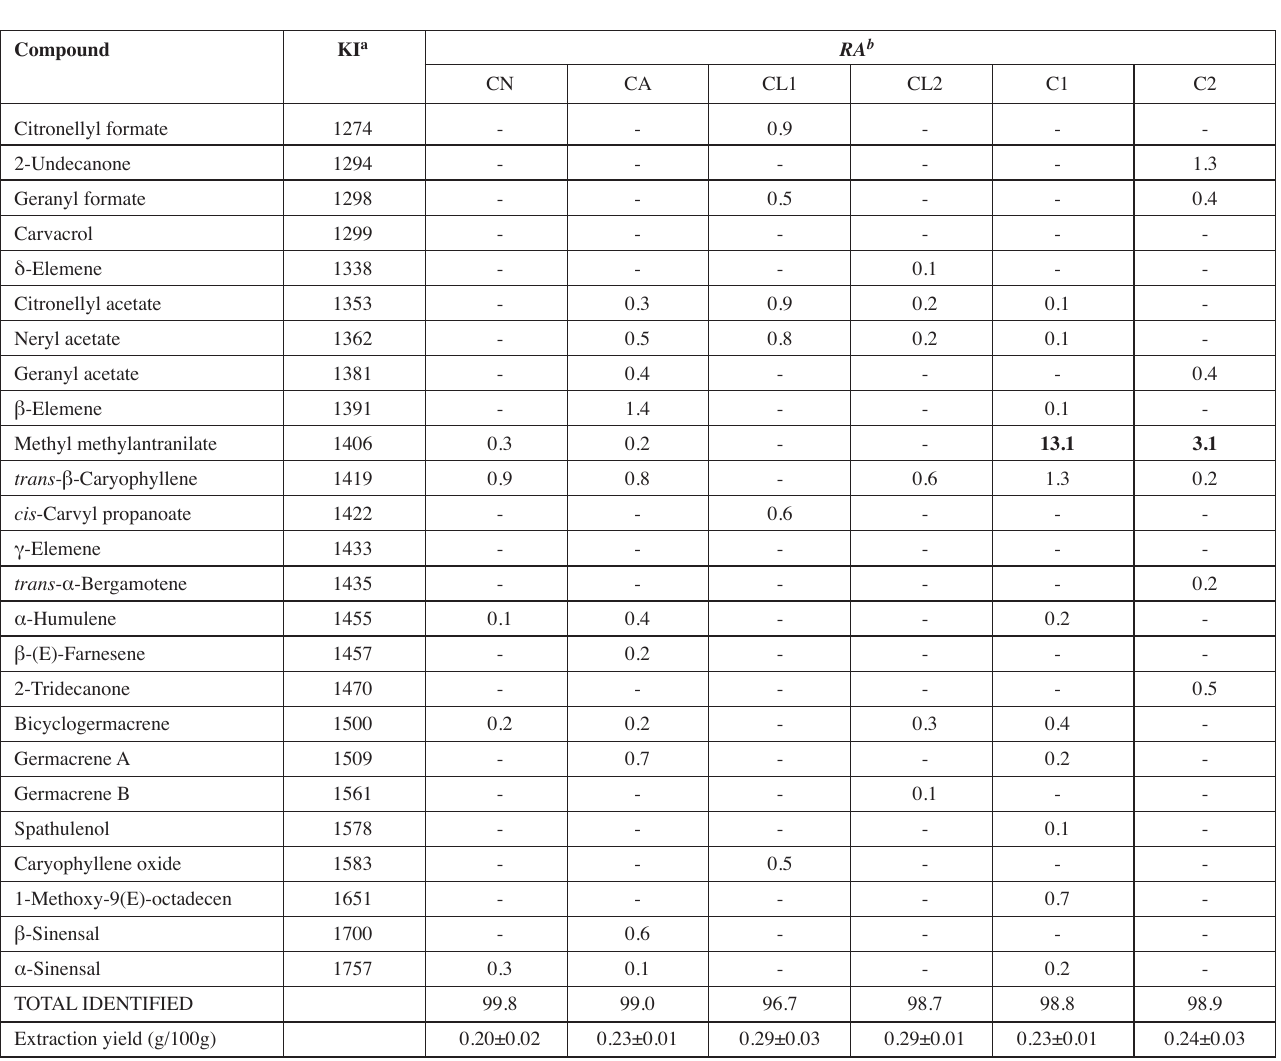
The major components (bold letters) of samples were identified by 13 C NMR